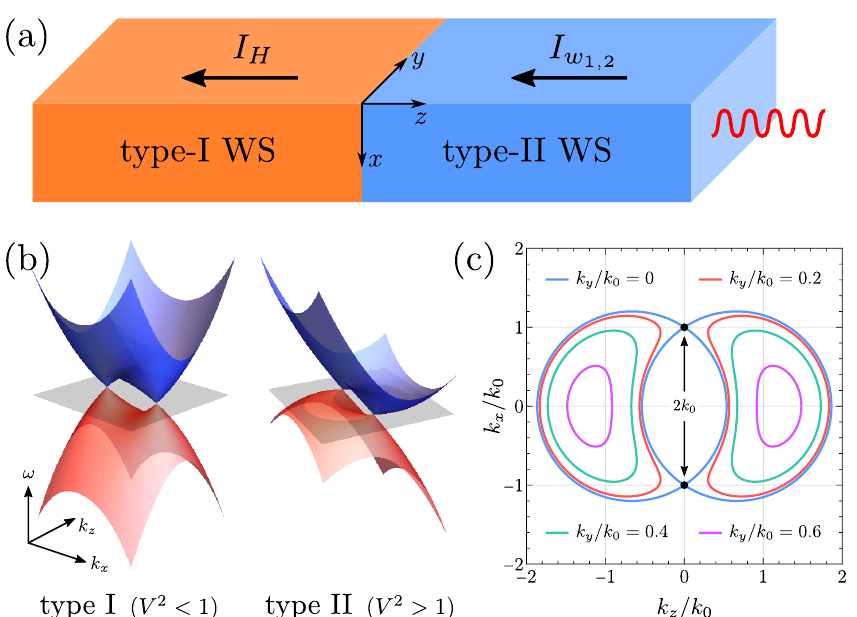
Figure 1: (a) Weyl semimetal (WS) heterostructure where the type-II region is irra- diated, which gives rise to a Hawking current between the type-II and type-I region. = 0. (c) Zero-energy Fermi surface in the type-II phase (b) Energy dispersion for k y = 1.2 where the Weyl nodes are shown as black for V / v F